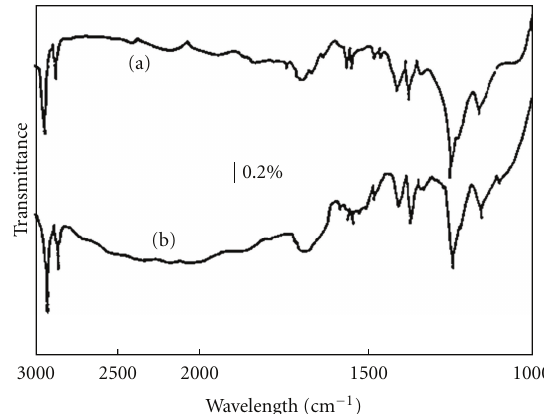
Figure 26: FTIR reflection adsorption spectra of the novel lubricant films prepared by (a) spontaneous adsorption method and (b) LB method on the surface of the magnetic layer.